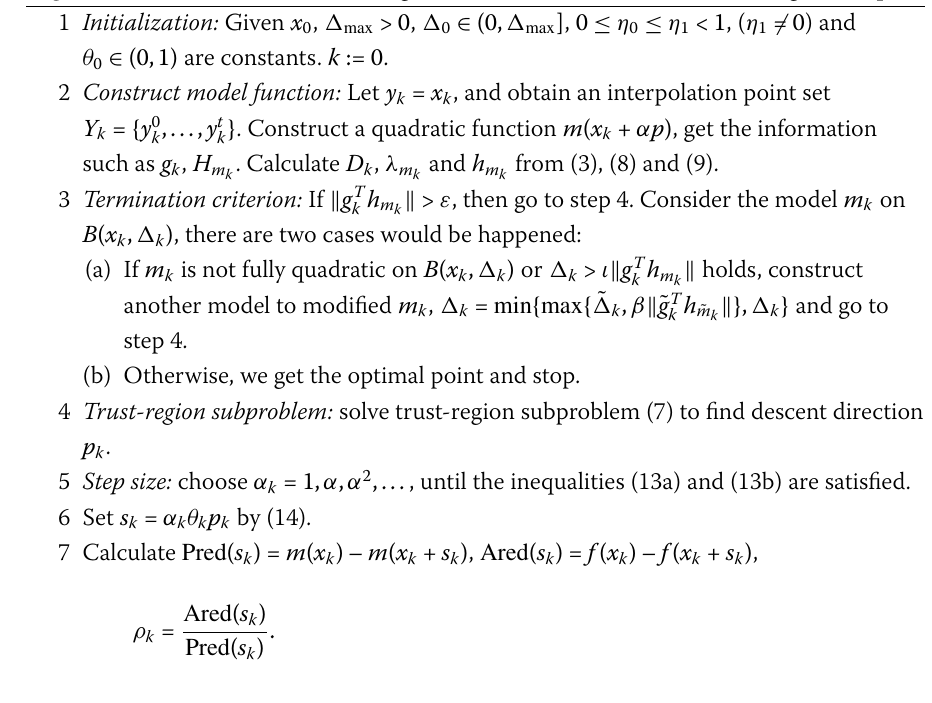
Algorithm 1 Derivative-free trust-region method with interior backtracking technique